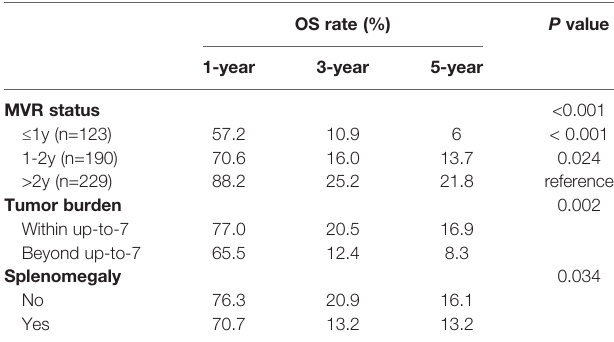
TABLE 6 | Survival analysis by duration of MVR, tumor burden or splenomegaly in the MVR group. OS rate (%) P